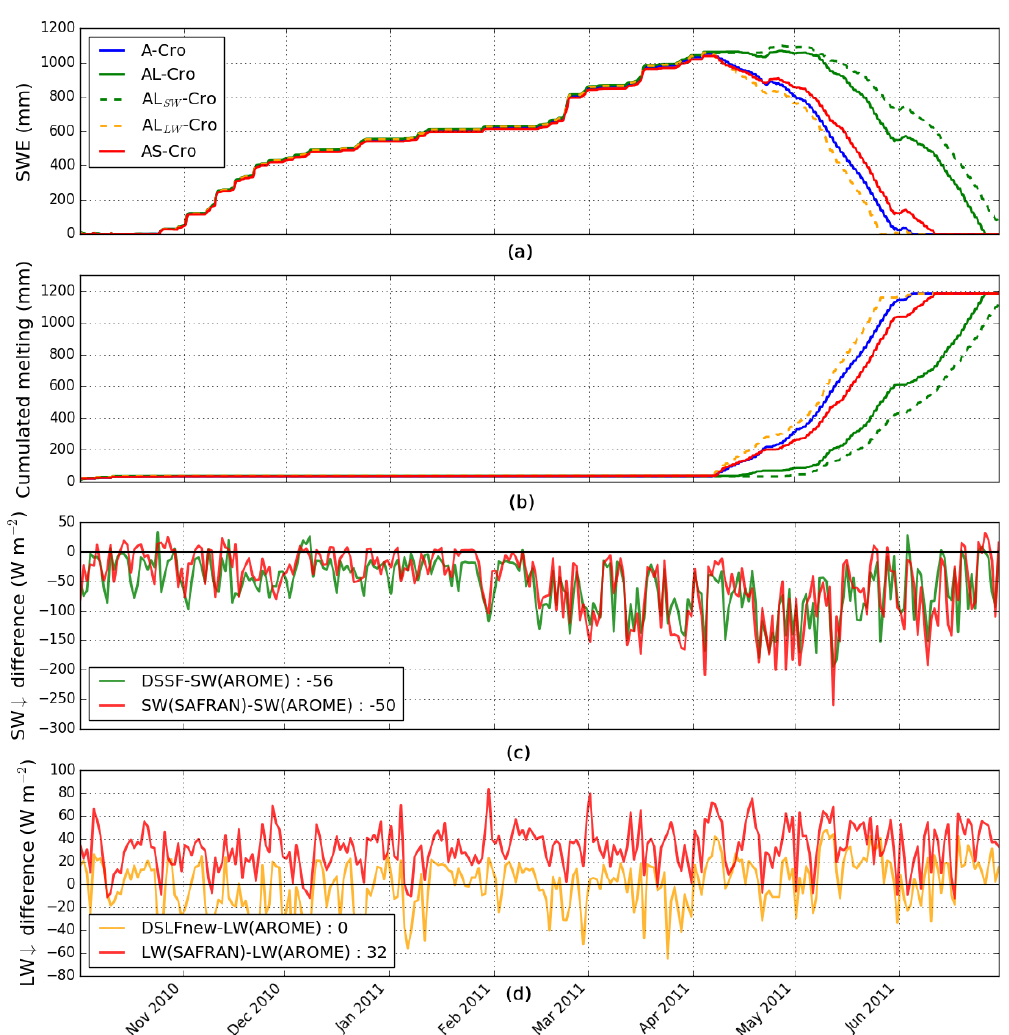
Figure 11. (a) Snow water equivalent simulated by A-Cro (blue), AL-Cro (green), AL SW (dashed green), AL LW (dashed orange) and AS- Cro (red) from 1 October 2010 to 30 June 2011 at point B in the Pyrenees (2459m, Fig. 9). (b) Cumulated melting represented with the same colours. (c, d) Mean daily irradiance differences with AROME for DSSF (green), DSLFnew (orange) and SAFRAN irradiances